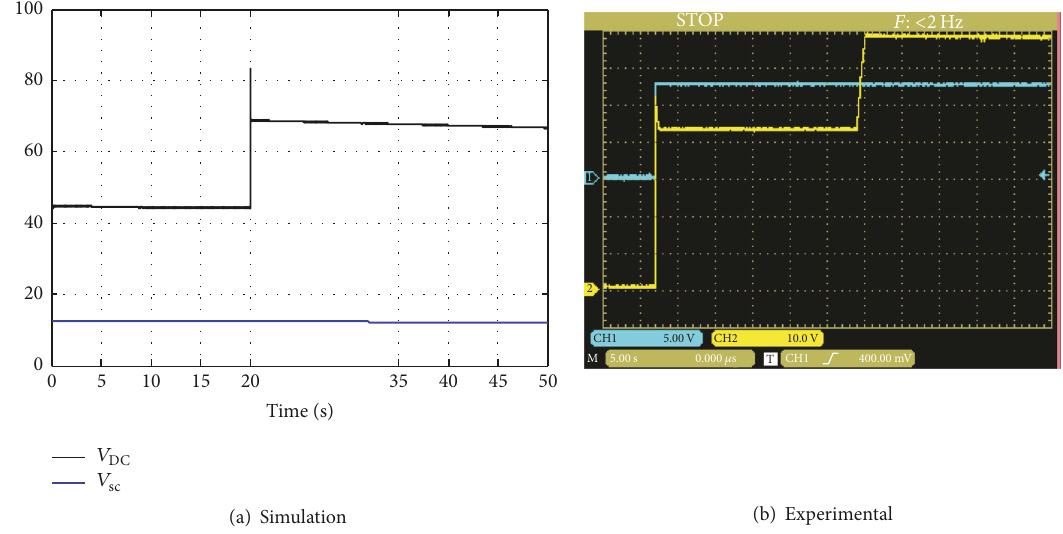
Figure 16: Simulation and experimental results for step change of the duty